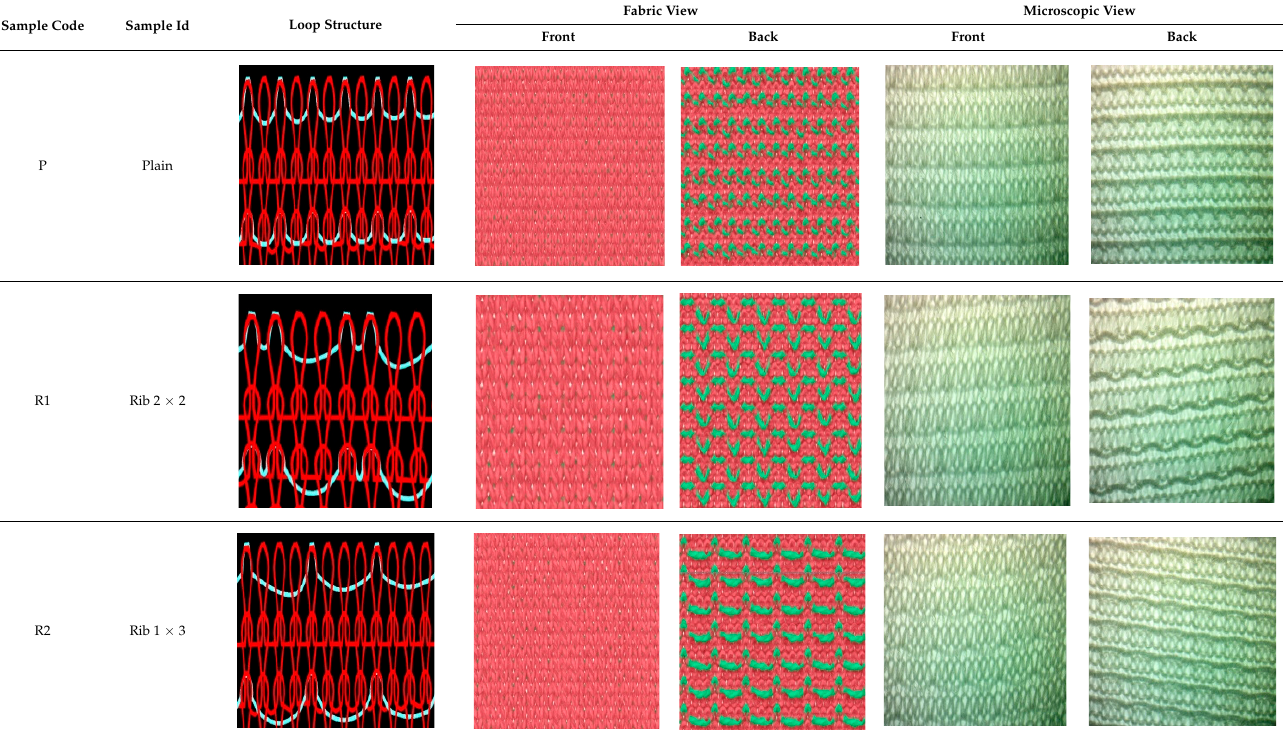
Table 3. Structural representation and systematic diagrams of the developed samples.